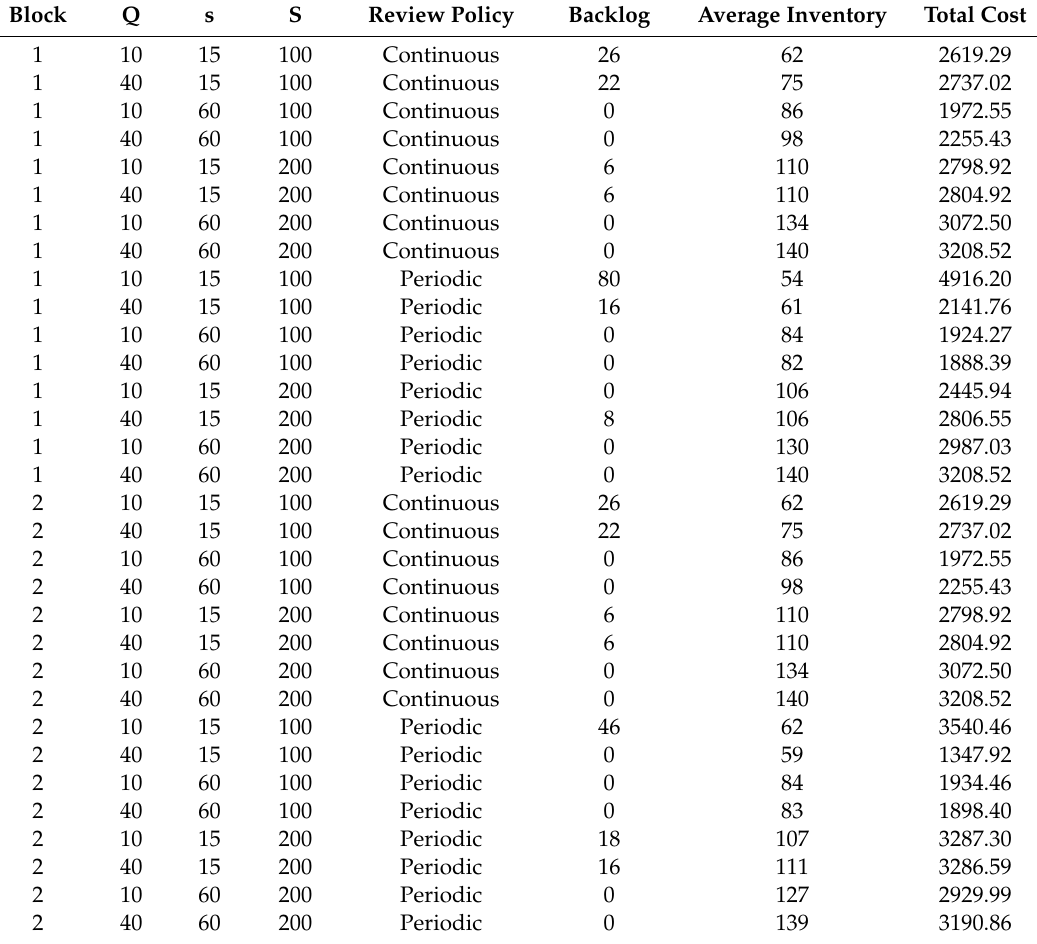
Table A1. Data set for running power analysis with 2 replications.